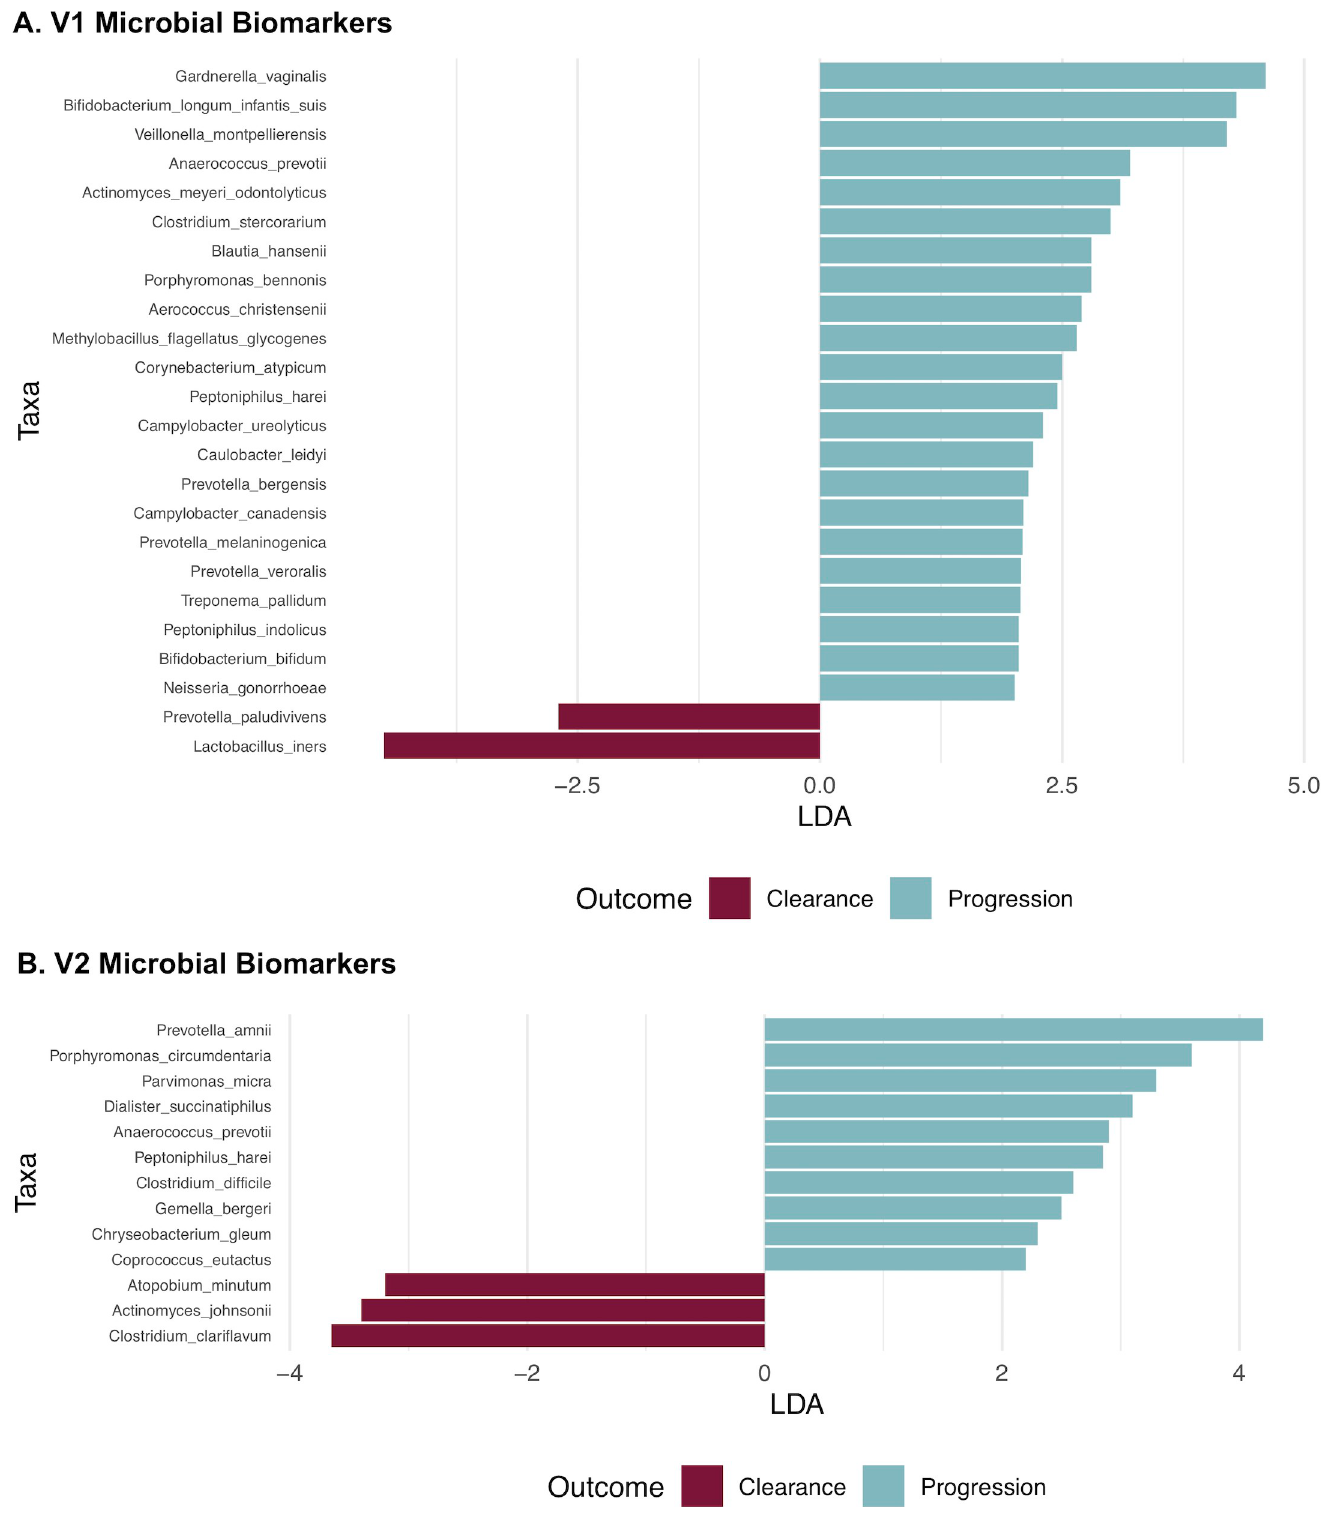
Fig 4. Bacteria associated with progression to CIN2+ identified using LEfSe. HR-HPV bacterial biomarkers for visit 1 (panel A) and visit 2 (panel B), comparing clearance vs. progression, were identified using the LEfSe tool. Only the significant bacterial taxa (LDA > 2.0) are shown for both visits.